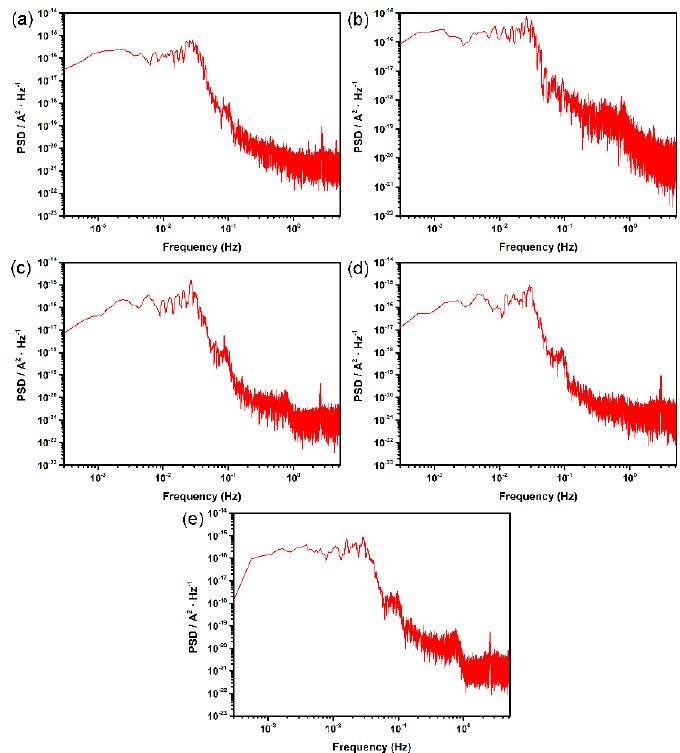
Figure 5. Current PSD plots for different surface roughness samples of DSS 2205 in 10% FeCl 3 at 50 ◦ C: ( a ) 180#; ( b ) 600#; ( c ) 1000#; ( d ) 2000#; ( e ) polished.